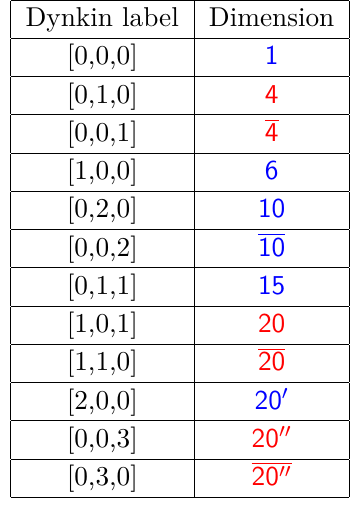
Table 7 . so (6) irreducible representations